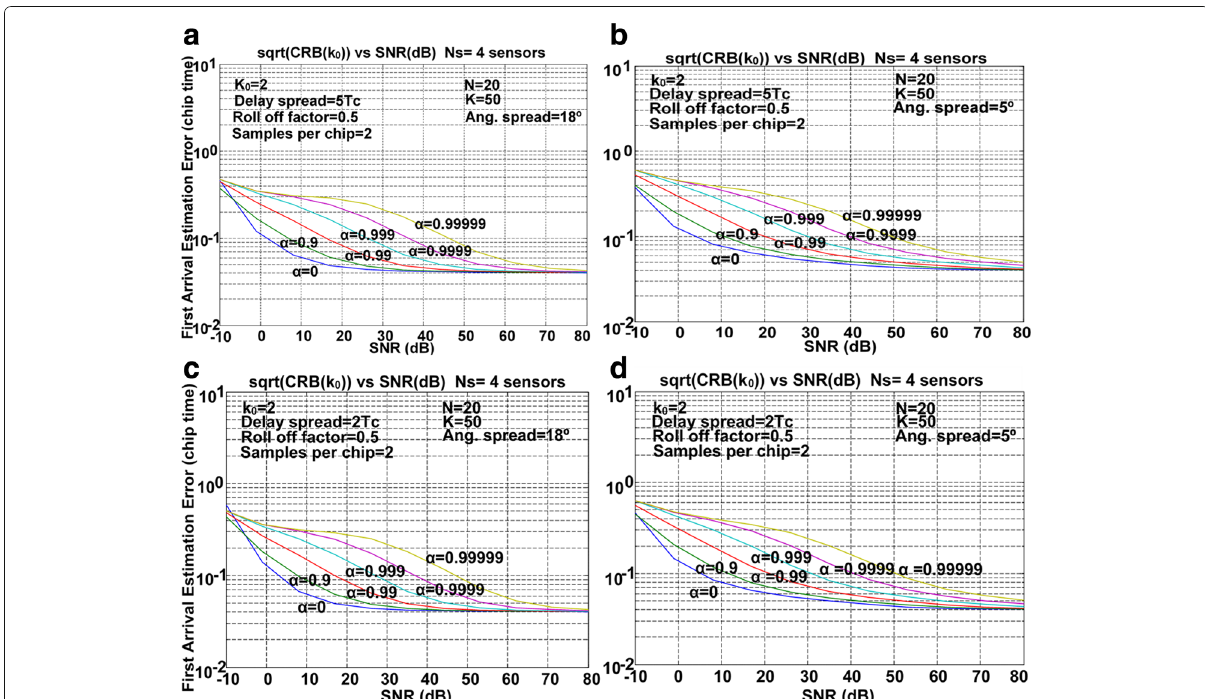
Fig. 6 CRB of the first arriving path k 0 for different values of the SNR. Results are provided for different values of the temporal correlation α , different values of delay spread, and different values of angular spread. Four sensors and 50 channel vector estimates are available. The sampling rate set to twice the chip rate, and a roll-off factor of 0.5. a Top left: delay spread set to 5 T c , angular spread set to 18°. b Top right: delay spread set to 5 T c , angular spread set to 5°. c Bottom left: delay spread set to 2 T c , angular set to 18°. d Bottom right: delay spread set to 2 T c , angular spread set to 5°